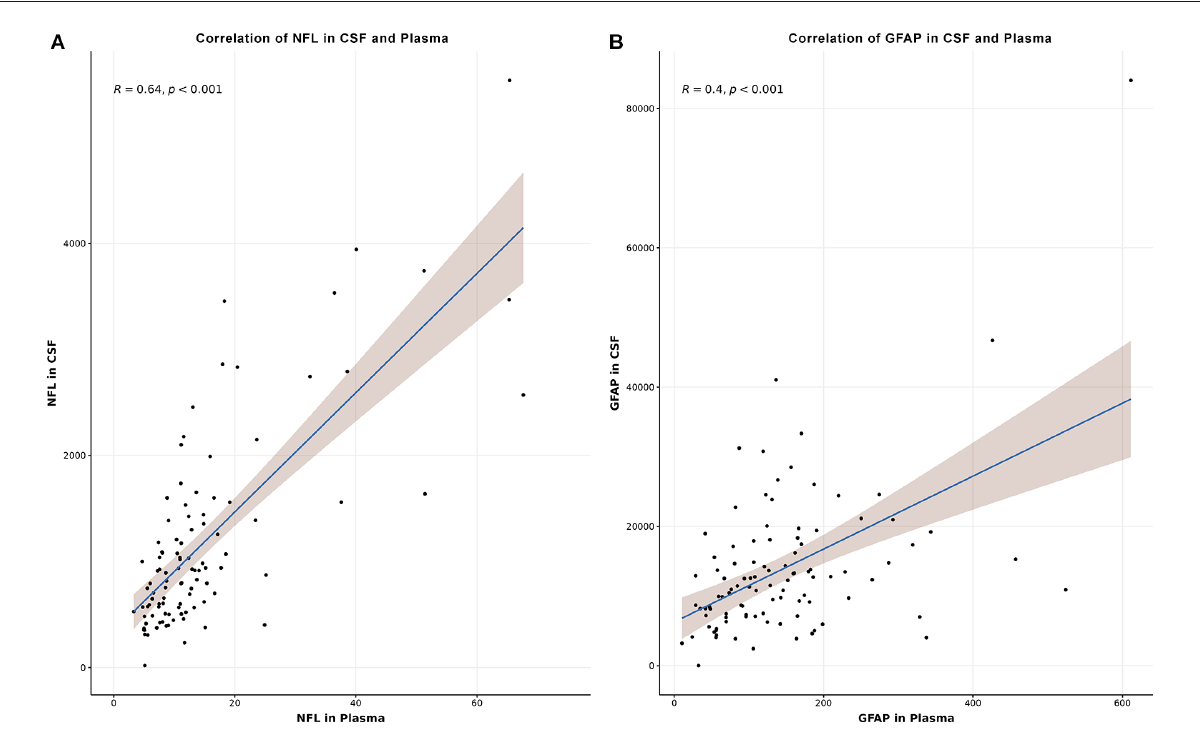
FIGURE2 Correlation of NfL in CSF and plasma (A) and GFAP in CSF and plasma (B) . Correlation was assessed using Spearman’s rank correlation coefficient. CSF , cerebrospinal fluid; NfL , neurofilament light chain; GFAP , glial fibrillary acidic protein.